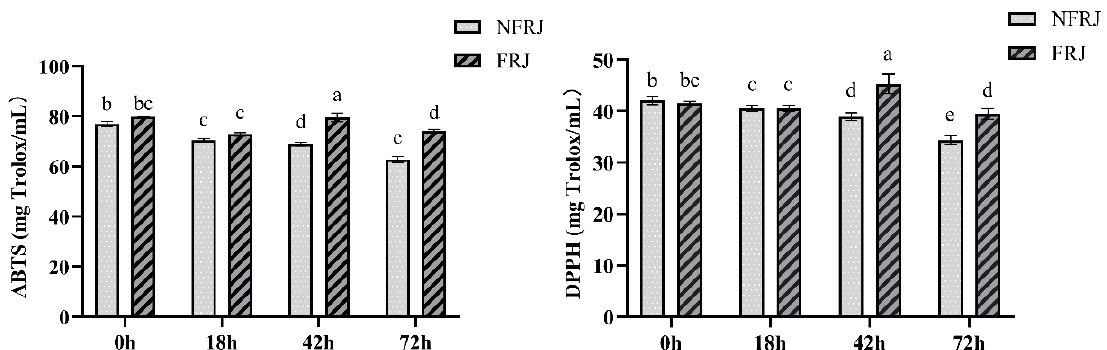
Figure 1. Antioxidant capacities (ABTS and DPPH) of NFRJ and FRJ. Different letters indicated significantly different at p < 0.05. ABTS:The 2,2 ′ -azino-bis (3-ethylbenzothiazoline-6-sulfonic acid) radical cation scavenging activity assay; DPPH:The 2,2-diphenyl-1-picrylhydrazyl radical scavenging activity; NFRJ:Non-fermented raspberry juice; FRJ: Fermented raspberry juice.